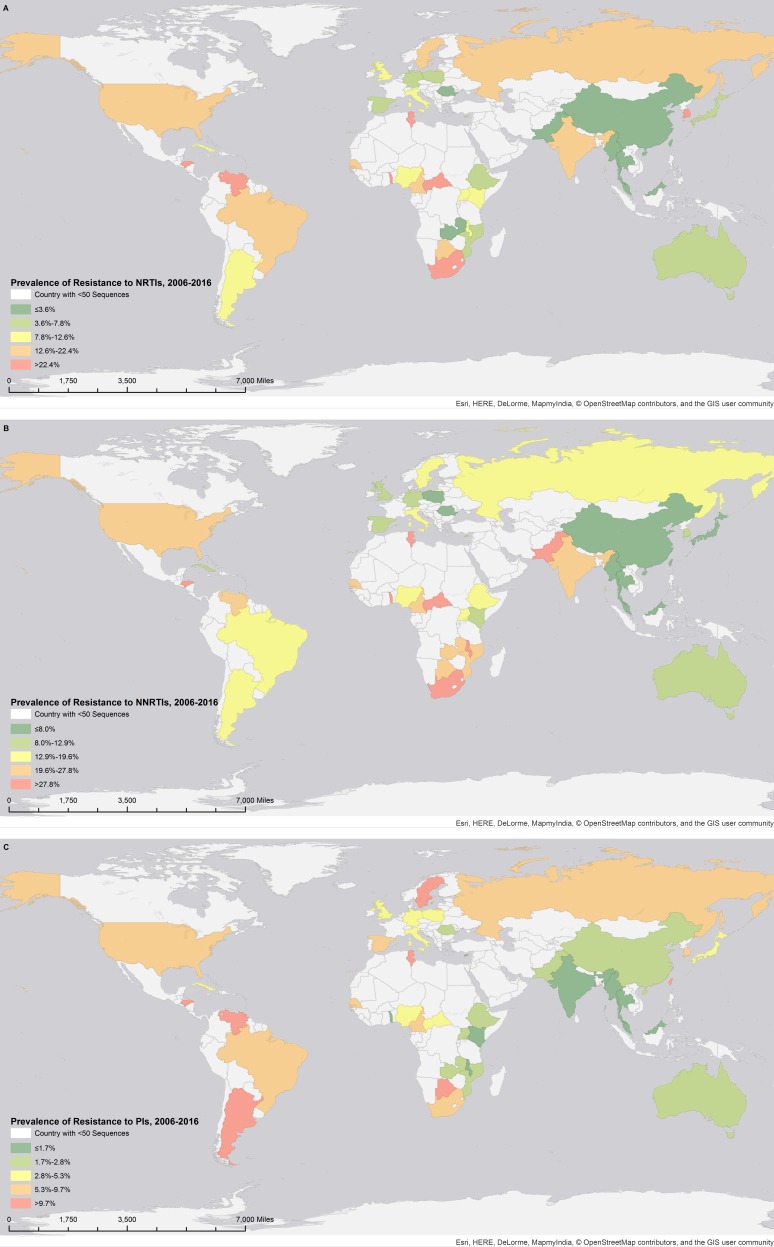
Prevalence of HIV drug resistance to NRTI (A), NNRTI (B), and PI (C) classes between 2006 and 2016.Image from OpenStreetMap, and the cartography is released under a CC-BY-SA license.